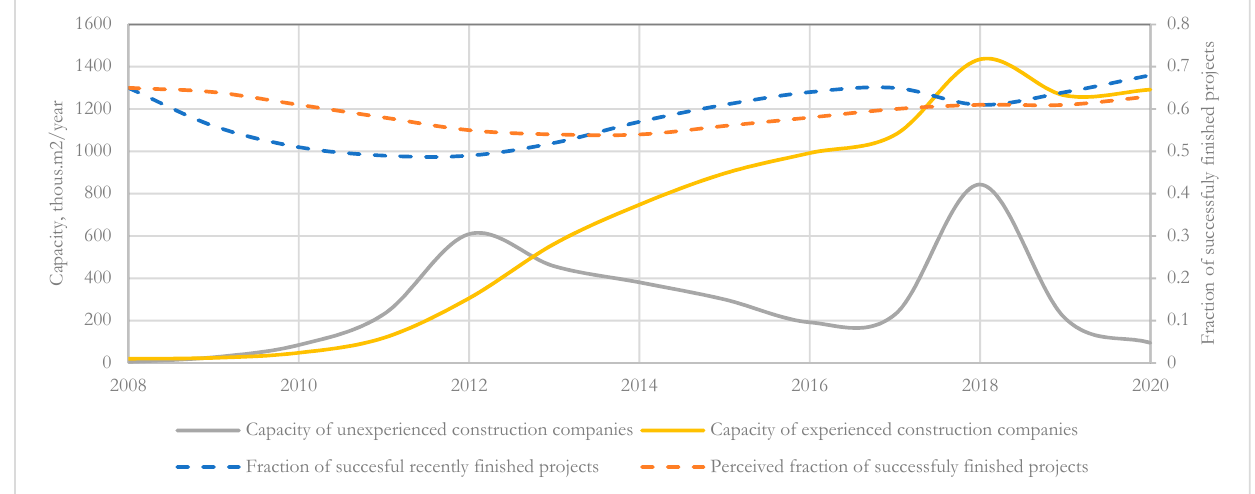
Figure 21. Simulated fraction of successfully completed projects and capacity of experienced and unexperienced construction companies with sustainable EU funding and penalty–reward scheme used.